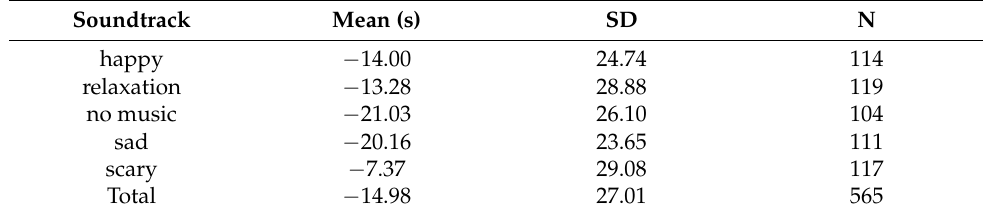
Table 4. Time estimate (delta) as a function of the